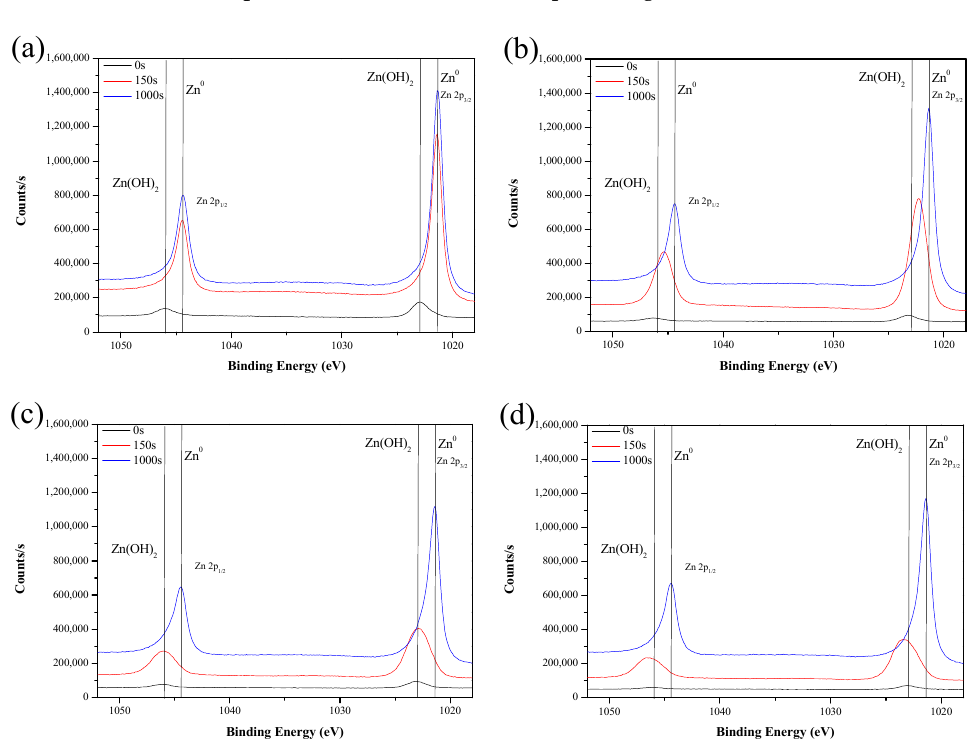
Figure 12. XPS depth profiles (multiplied by a factor of 50) of Co, F, and C in Zn–Ni alloy trivalent chromium coatings by Ar ion etching, showing atomic weight percent of ( a ) C, ( b ) F, and ( c ) Co. Figure 13 shows the XPS binding energies of Zn peaks from alkali Zn-Ni alloy plating at etch times of 0, 150, and 1000 s corresponding to regions in XPS depth profiles (Figure 11). On the surface (0 s), peaks presenting Zn(OH) 2 were detected, and these peaks became more vague after either adding chromate coating or increasing NaF concentration. For regions 150 s, XPS spectrum suggested the presence of metallic Zn without NaF and chro- mate. However, when adding chromate and increasing NaF, the Zn 2p peaks shifted to Zn(OH) 2 peaks. The XPS spectra manifested metallic Zn peaks at 1000 s regardless of NaF and chromate. The XPS binding energies of Ni peaks are depicted in Figure 14. No peak of Ni 2p was observed on the surface (0 s) in all cases of NaF and chromate. At 150 s, peak Ni 2p shifted from metallic Ni to Ni 2+ with the addition chromate before vanishing with the addition of NaF. XPS spectra at 1000 s showed Ni 0 peaks regardless of NaF and chro- mate. The XPS binding energies of O peaks in Figure 15 indicate the presence of CrO 3 and CrO 2 peaks. Therefore, the chromate film was formed when NaF concentration was in- creased. The H 2 O peak is attributed to the moisture on the surface. are attributed to noise caused by Zn; the composition table also indicates 0% Cr. In (b), i.e., for NaF 0% 60 s etch time, only the Zn noise peak is observed because Cr fully pene- trated into the Zn–Ni alloy plating layer. In (c) NaF 50% and (d) NaF 100% 60 s etch time chromate coatings, the spectra reveal Cr 2 O 3 and Cr(OH) 3 peaks and a Zn noise peak. These observations imply that the chromate thickness increases as the NaF concentration in- creases.